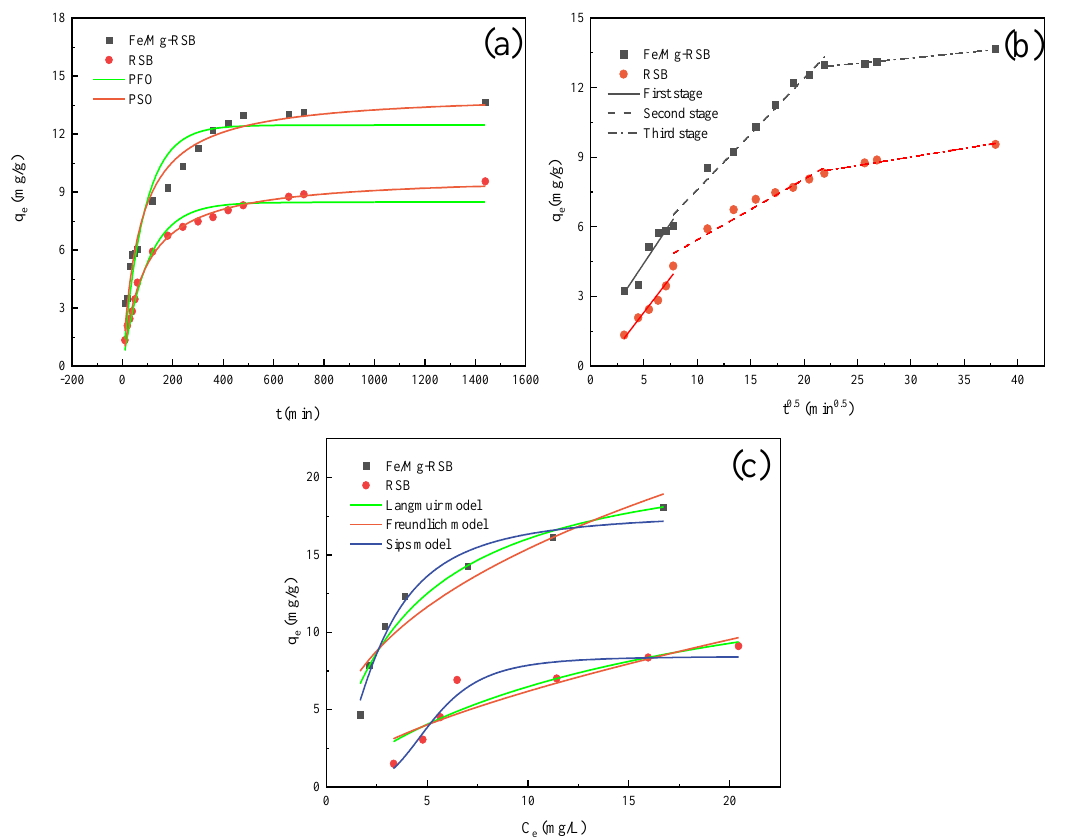
Figure 5. Adsorption kinetics ( a , b ) and isotherm ( c ) of CQP on biochars.